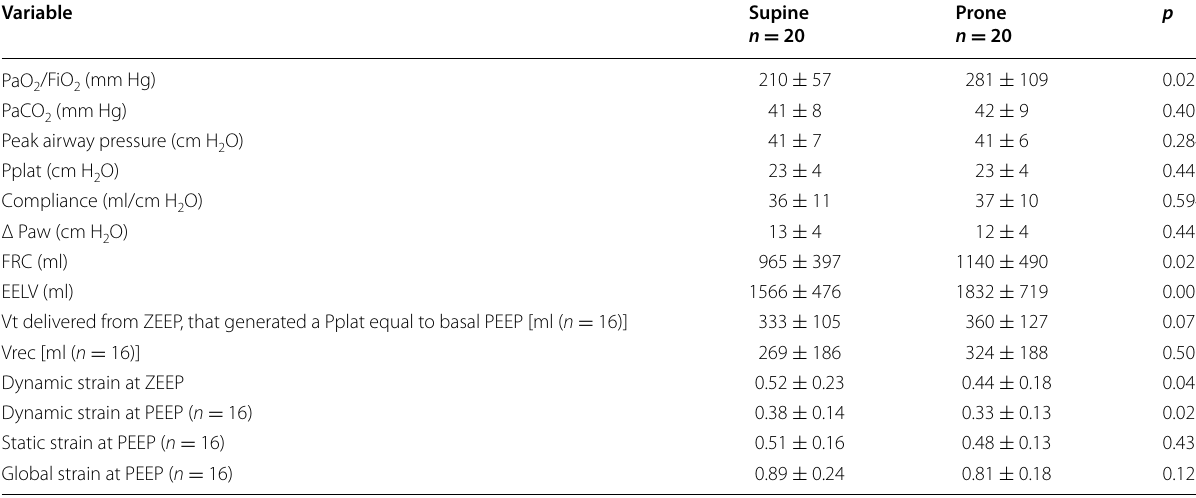
Data are presented as mean strain at